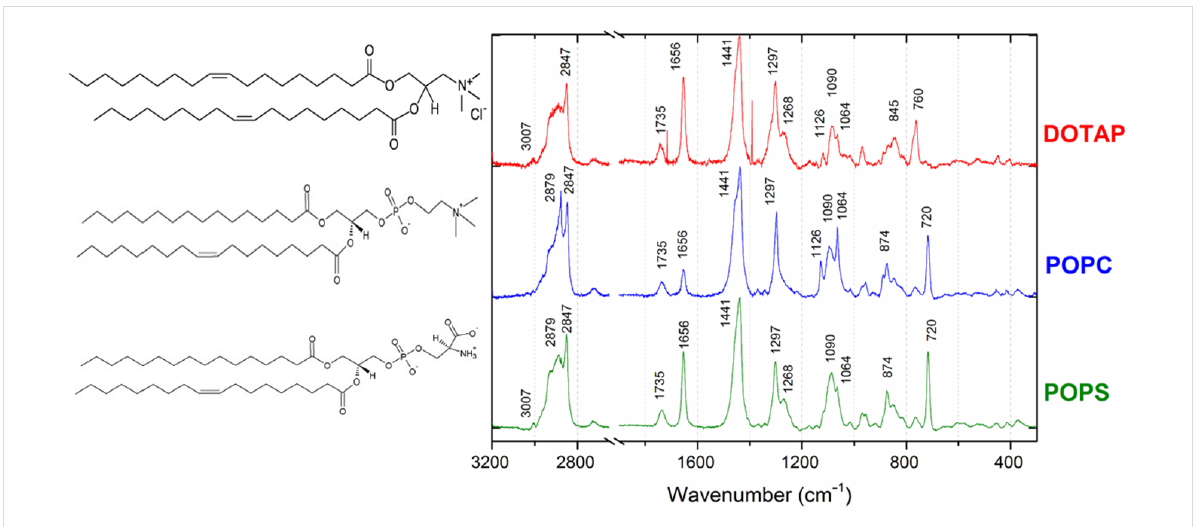
Figure 3: Raman spectra of lipids in powder form on flat Au substrates, with their molecular structures.